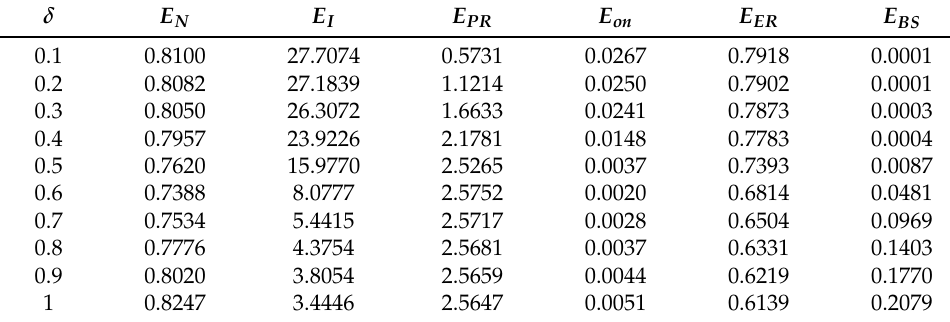
Table 4. Effect of δ for ( S , s , c , η , λ , µ ) = ( 40,15,3,2.6,4,7 )